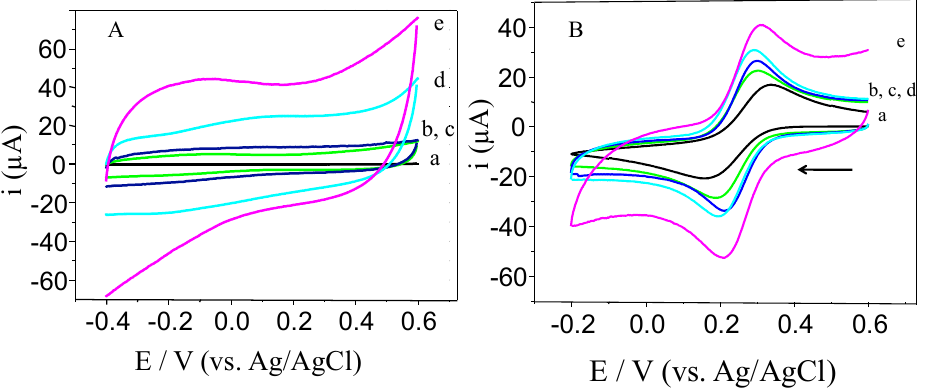
Figure 2. Cyclic voltammograms obtained in ( A ) 0.10 M PBS, pH 7.0 and ( B ) 2 mM ferricyanide solution, KCl 0.1 M. GCE (a, black line), GCE/CRGO (b, green); GCE/hTRGO (c, blue); GCE/ERGO (d, cyan), and GCE/TRGO (e, magenta) (1.0 mg/mL) dispersed in PBS at pH 7.0. Scan rate, 0.1 V/s.